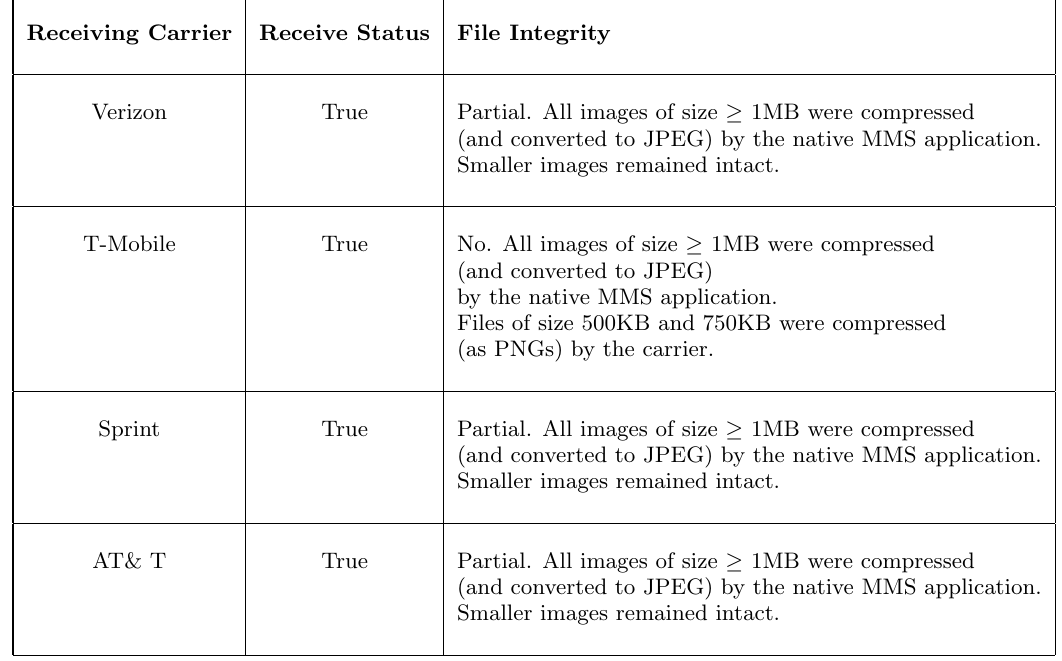
Table 2: Summary of carrier restriction on in-coming MMS message size for the big-four cellular service providers in North